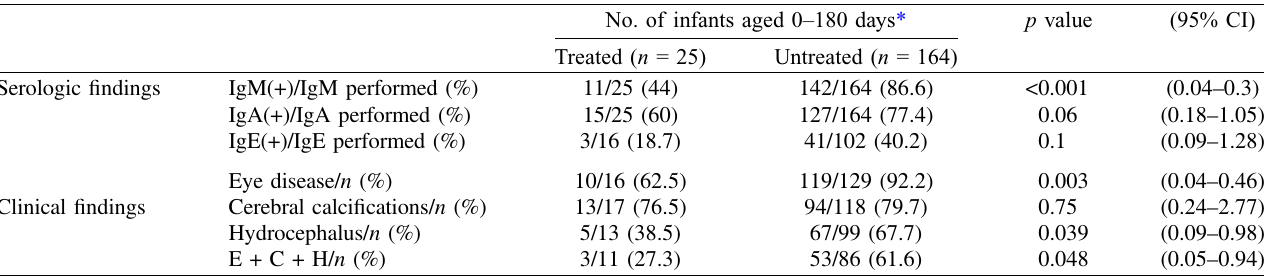
Table 2. Serologic and clinical fi ndings in infants with congenital toxoplasmosis born to treated and untreated mothers in the United States. No. of infants aged 0–180 days*